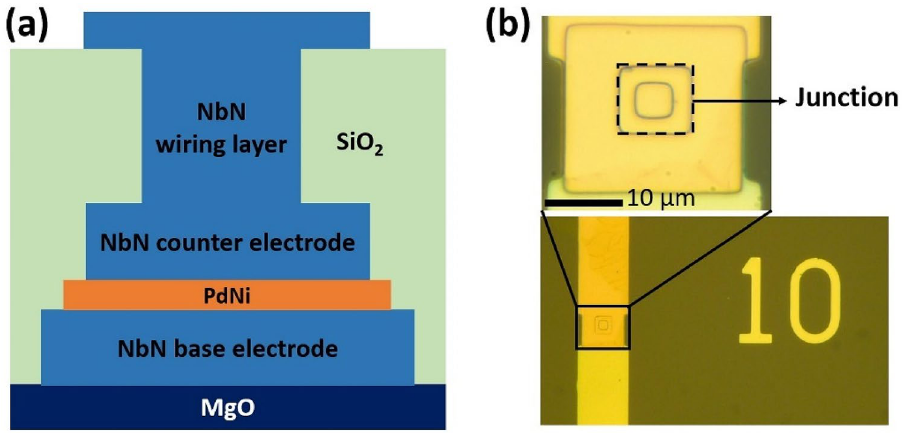
Figure 1. ( a ) Schematic cross-sectional view of the NbN/PdNi/NbN junction on an MgO substrate. ( b ) Microscope image of 10 × 10 µm 2